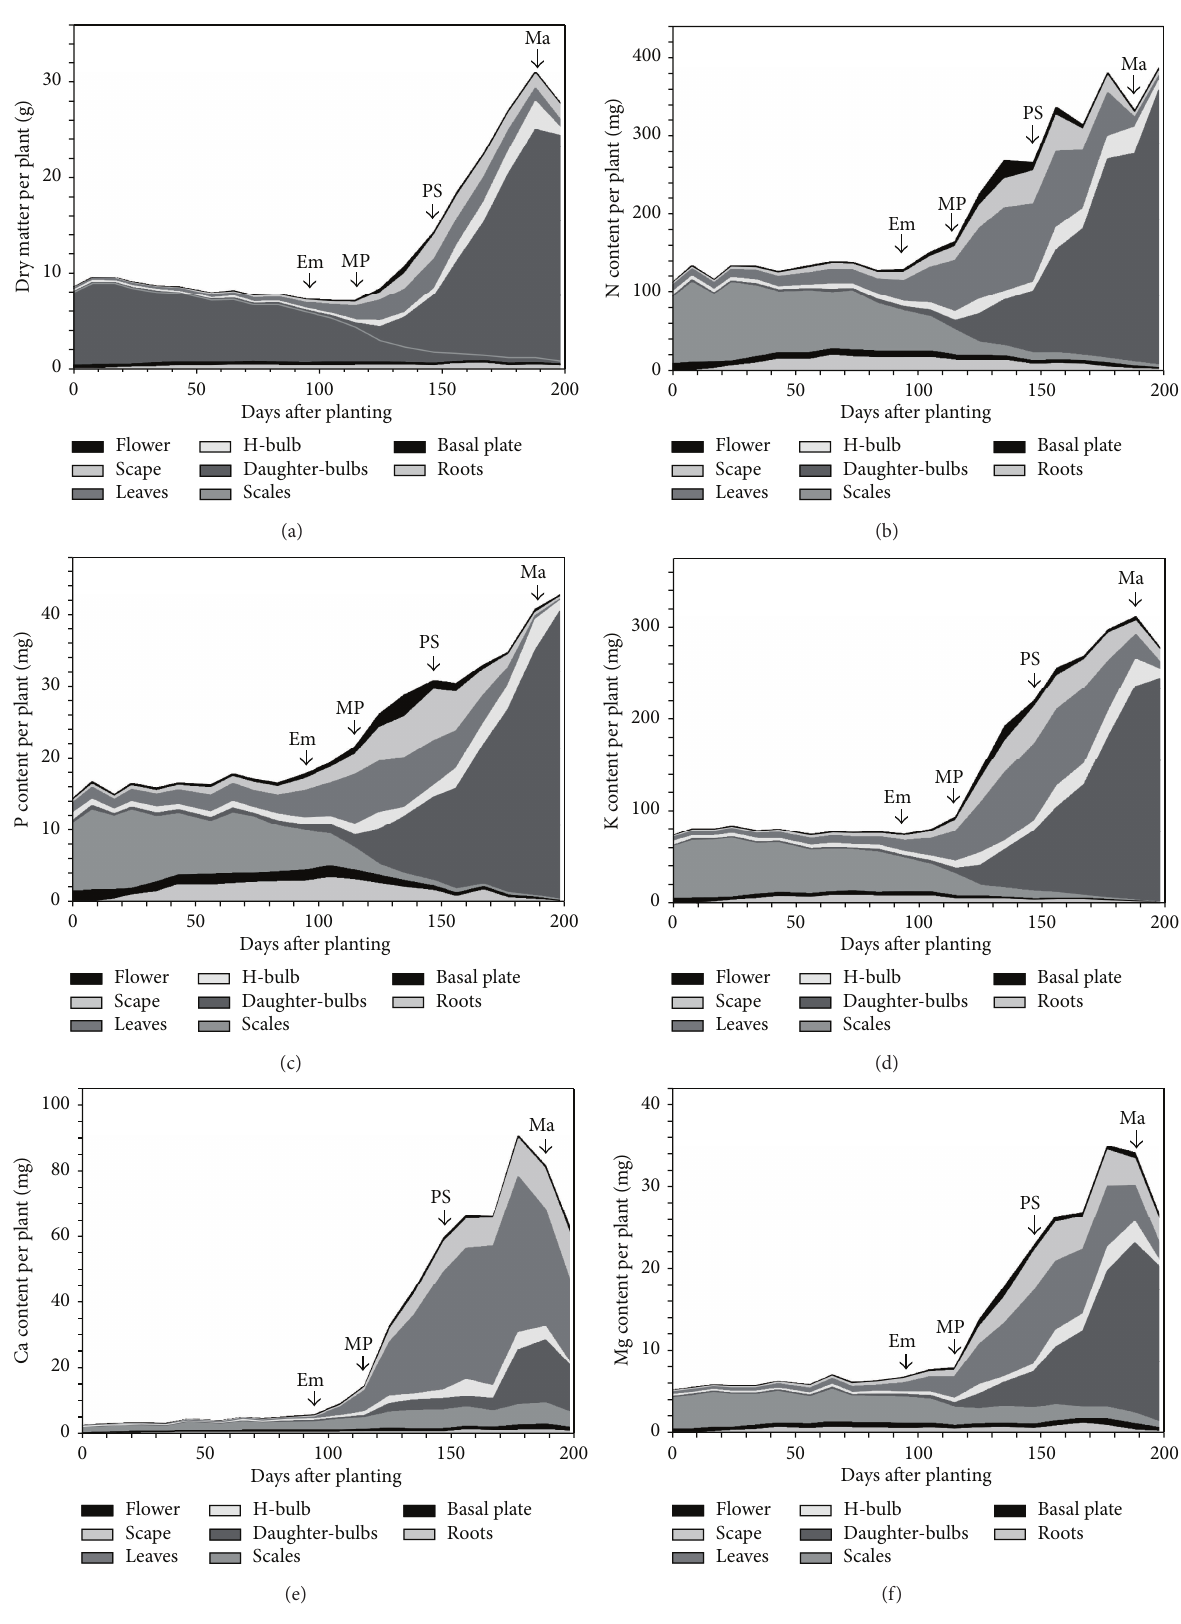
Figure 2: Profile showing the allocation of dry matter (a), N (b), P (c), K (d), Ca (e), and Mg (f) to organs of T. gesneriana “Paul Richter” during the growing season. Organs appear within each graph in the same order (top to bottom) as listed in the key. Data are plotted additively with vertical distances between lines indicating the quantity of a particular nutrient in each organ. The arrows indicate the dates of shoot emergence (Em), minimum plant (MP) dry matter, peak shoot (PS) dry matter, and bulb maturity